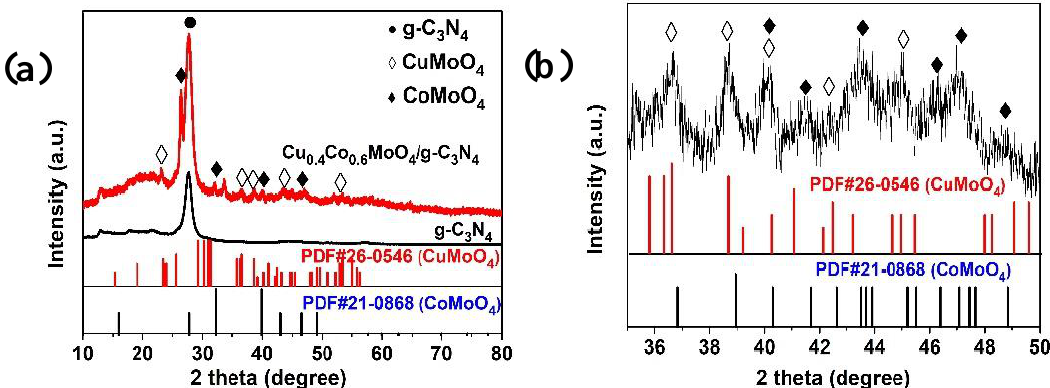
Figure 1. XRD patterns of graphitic carbon nitride (g-C 3 N 4 ) and Cu 0.4 Co 0.6 MoO 4 / g-C 3 N 4 ( a ) and enlarged XRD pattern of Cu 0.4 Co 0.6 MoO 4 / g-C 3 N 4 ( b ).